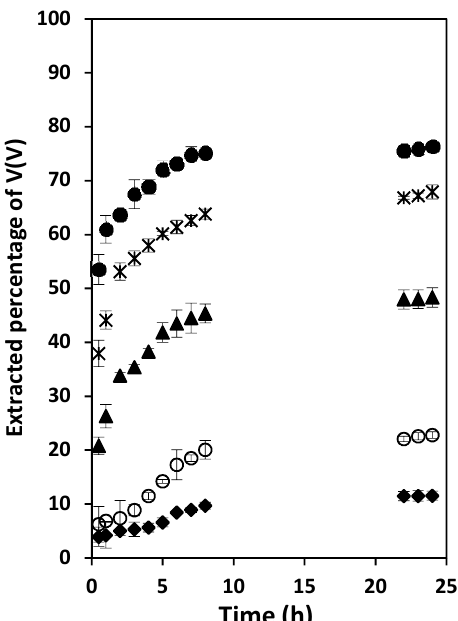
Figure 4. Variation of the extraction percentage of V(V) during its extraction from aqueous solutions adjusted to pH 1 , 1.5 ○ , 2.0 ▲ , 2.3 , or 2.5 ●. Experimental conditions: aqueous solution composition − 50 mg L −1 V(V) and 0.2 mol L −1 sulfate; PIM composition 50 wt% PVDF-HFP, 40 wt% Aliquat ® 336 and 10 wt% DBP; PIMs/aqueous source solution contact time and solution temperature 24 h and 22 ± 1 °C, respectively. Error bars = ± SD.